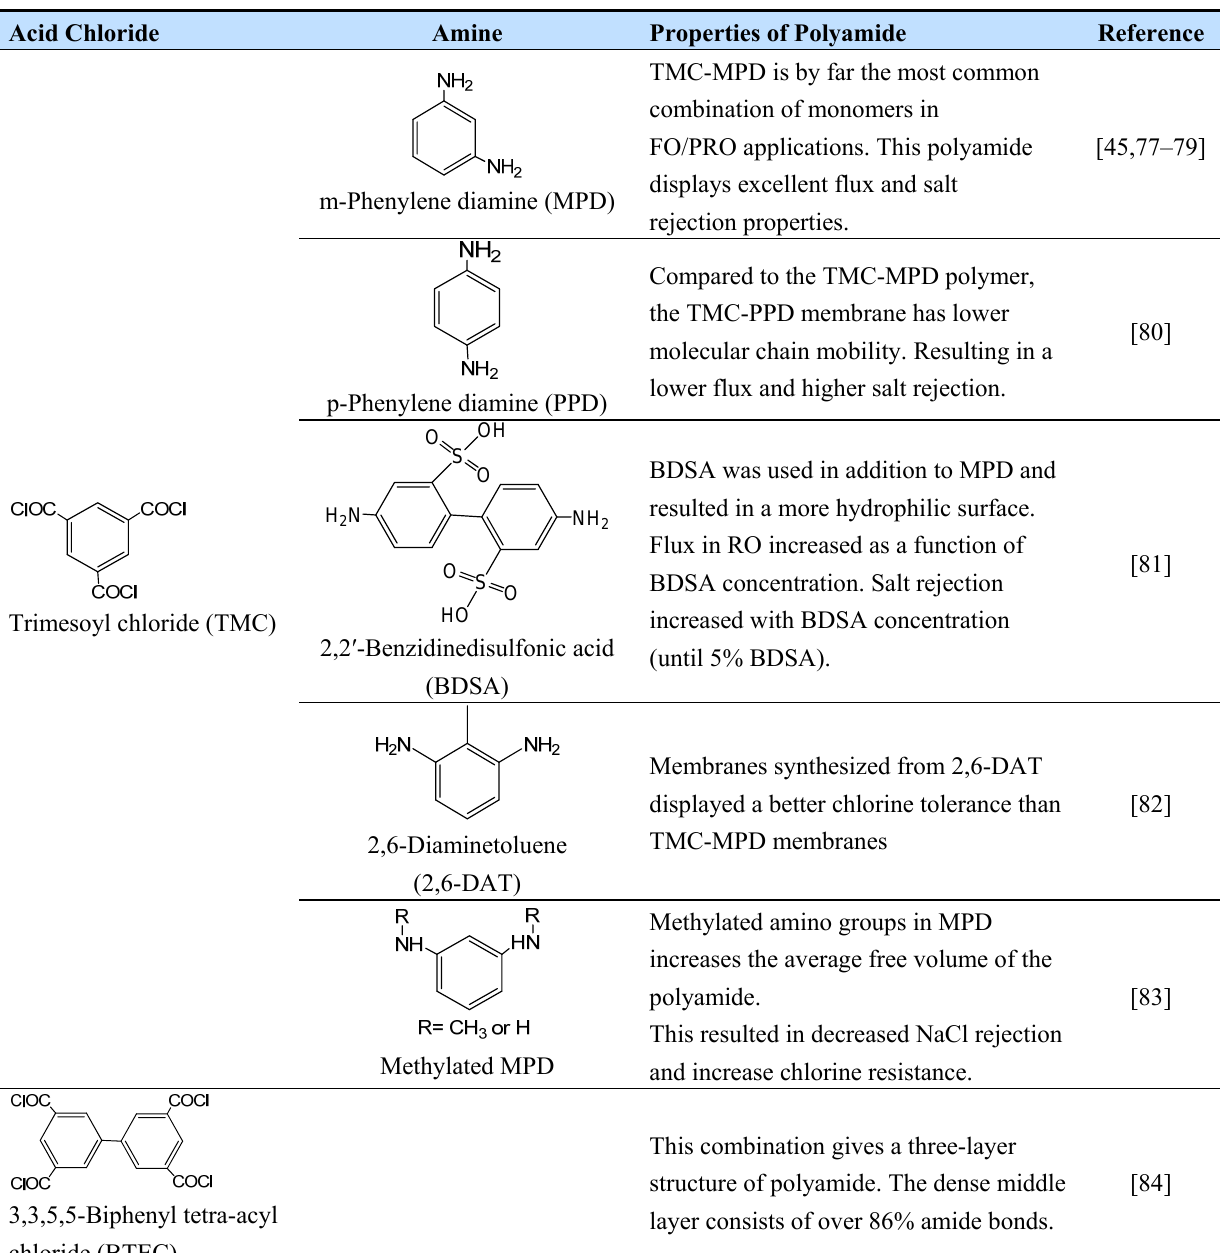
Table 2. Some examples of amine-acid chloride combinations used in interfacial polymerization in osmotic membrane